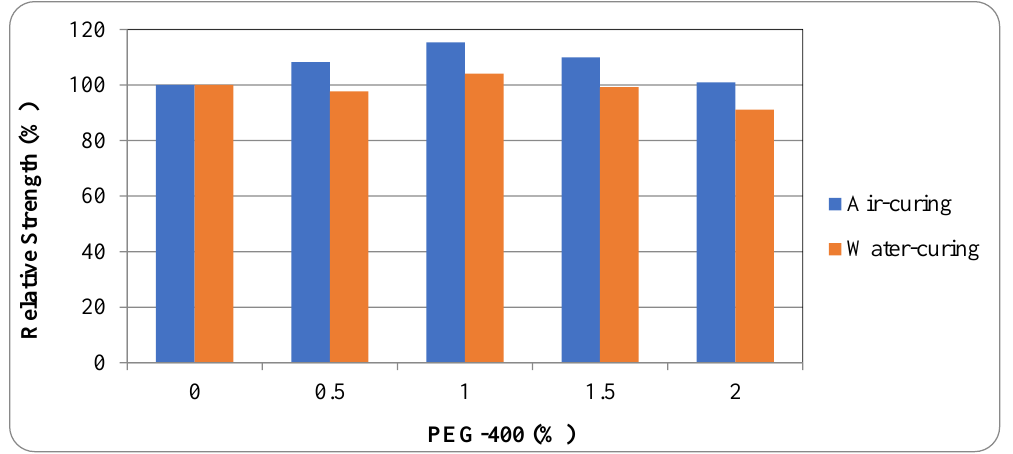
Figure 7. Relative compressive strength of mixes containing PEG-400 to control mix exposed to air and water curing at 28 days.